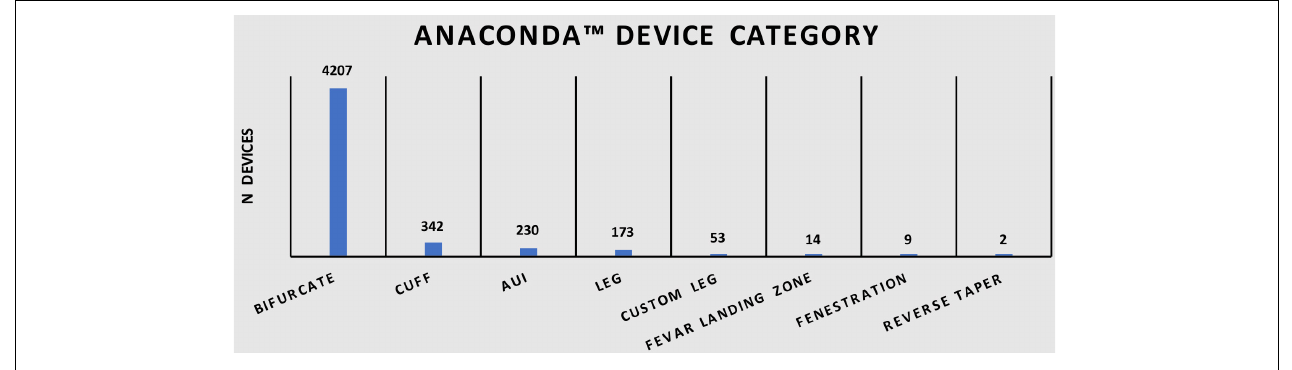
FIGURE 1 | Illustration of AnacondaTM device